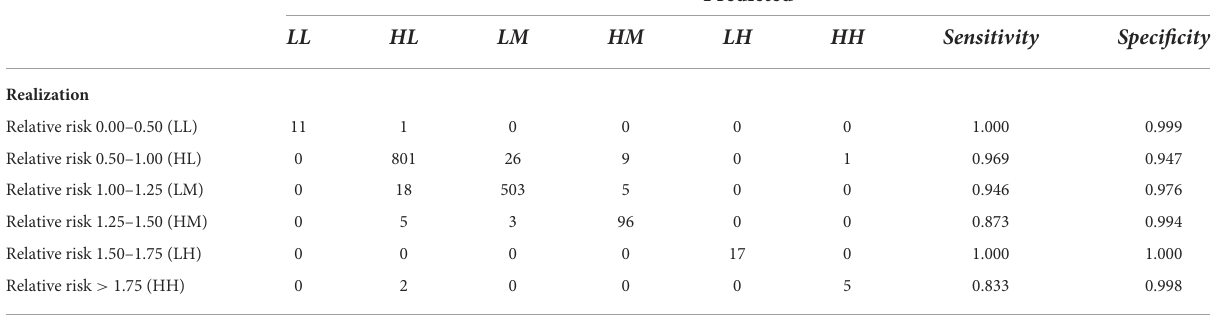
TABLE 6 Confusion matrix for October 2021 prediction of relative risk of COVID-19 infection.